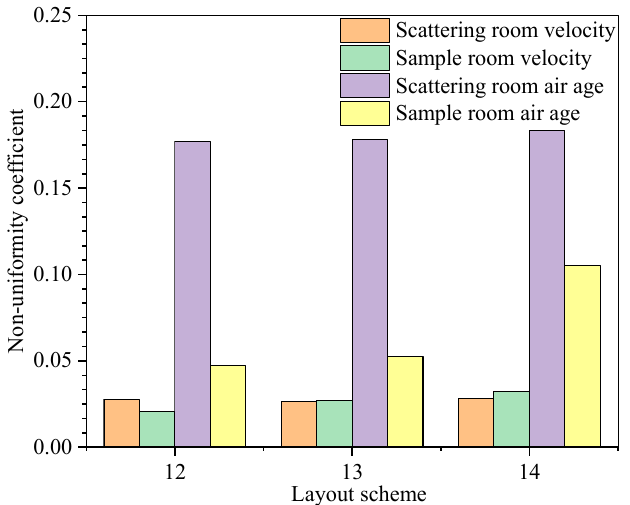
Figure 12. Comparison of three outlet height non-uniformity coefficients (The scattering room z = 1.6 m and the sample room z = 2.4 m).